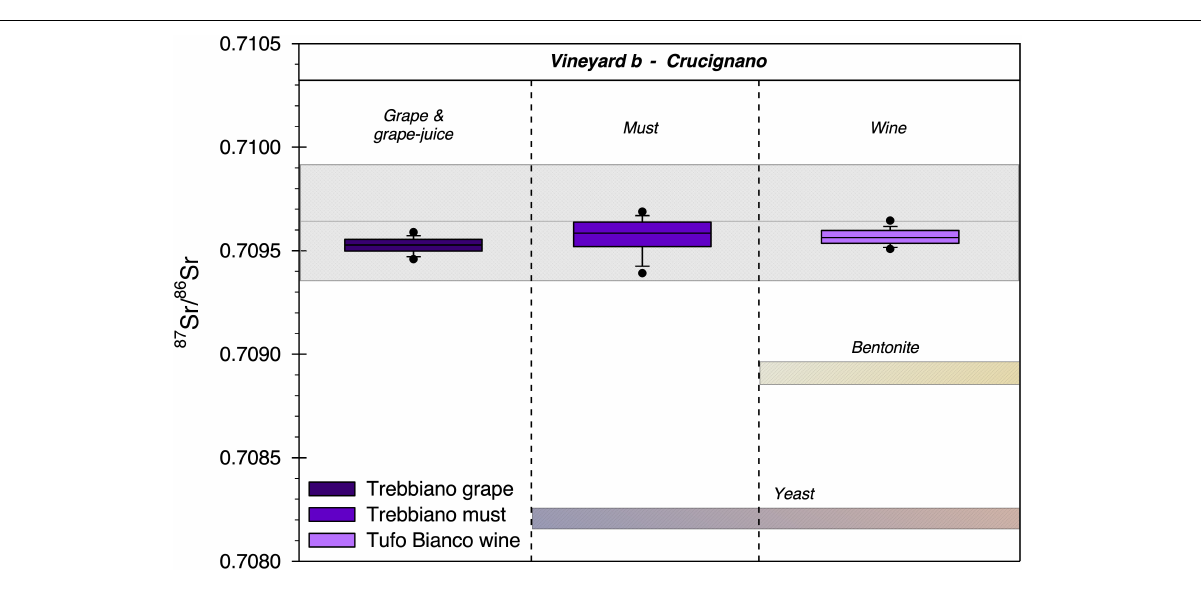
FIGURE 5 | 87 Sr/ 86 Sr values in grape, juice, musts, and wine for the Tufo Bianco wine (from the 2015 vintage year). Tufo Bianco is high-quality varietal wine,composed by Trebbiano alone, which was harvested in 2015 from the area of Crucignano (vineyard b ). The box plot features are reported through text and in thecaption of Figure 2 . The gray pattern represents the whole range of variability of the soil bioavailable fraction; the solid line represents the mean value. The shadedbars represent the isotopic range of the analyzed additives, bentonite and yeast, respectively. The length of the bars depends on the wine-making step in which suchadditives are introduced, thus the different matrix in which we investigated their potential